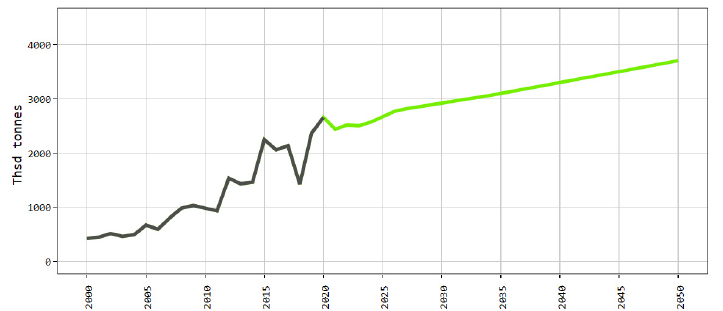
Figure 10. Wheat production in Latvia, in 2000–2020, with a projection for 2021–2050, thousands of tons [62].